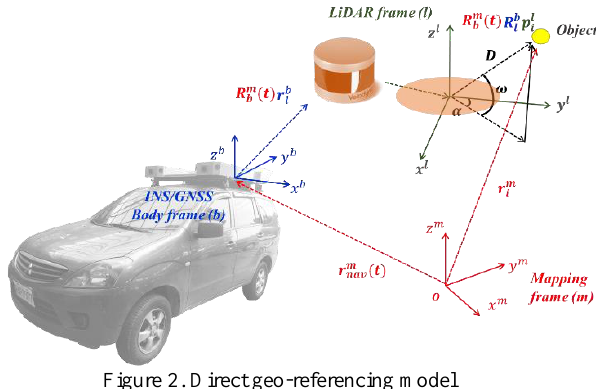
Figure 2. Direct geo-referencing